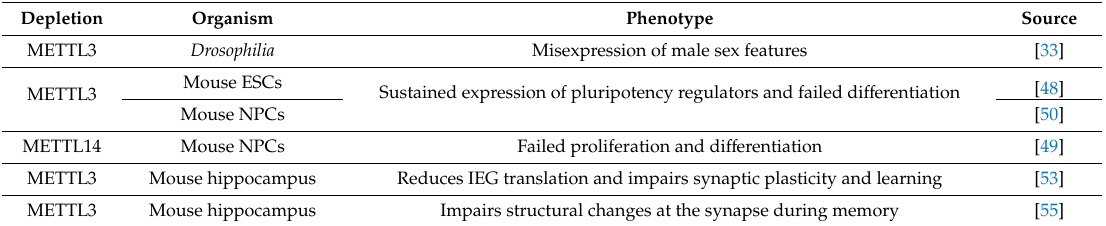
Table 1. Summary of Outcomes of methyltransferase complex (MTC)